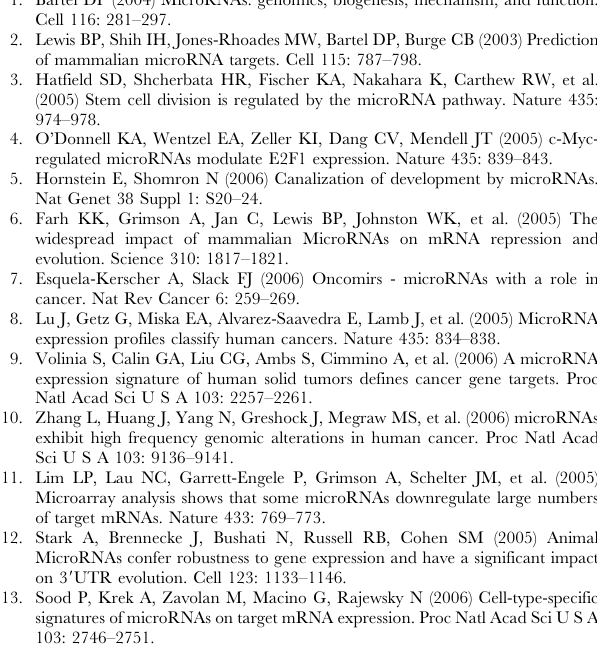
Table S4 MiR-seeds found to be the most significantly